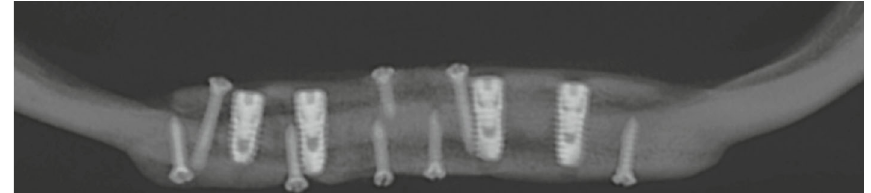
Figure 3: Reconstructed panoramic radiograph of patient ’ s cone beam computed tomography (CBCT) — 4-month